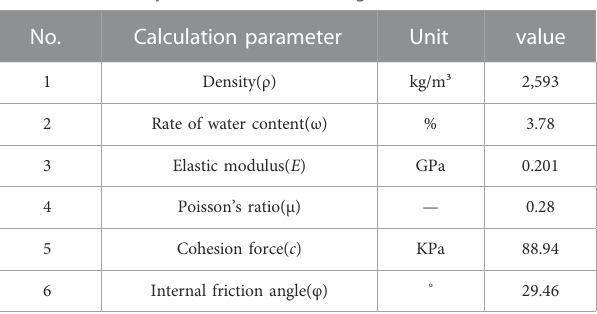
TABLE 1 Calculation parameters of surrounding rock in the numerical